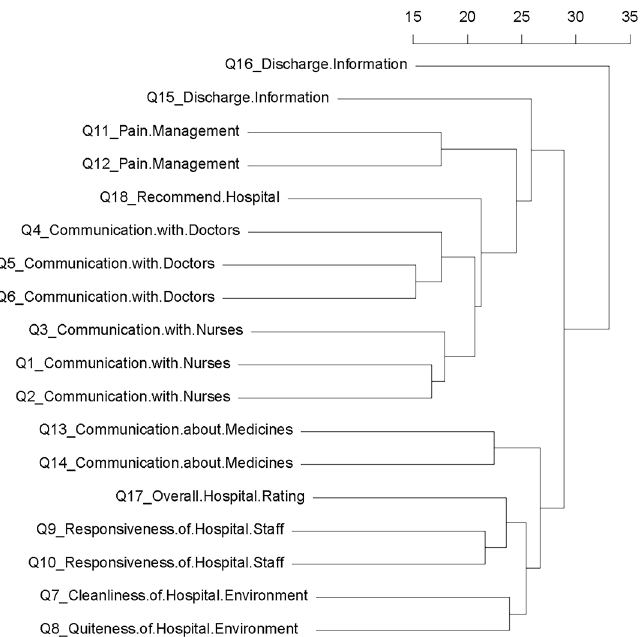
Fig 1. Hieratical clustering on binary responses for 18 questions. The cluster consists of similarity of 18 questions (see